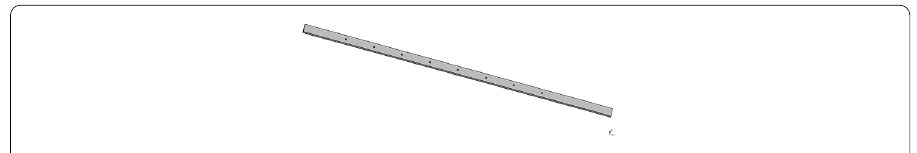
Fig. 6 Beam with holes. Sample beam with 8 holes for natural frequency analysis, geometry created according to [1]